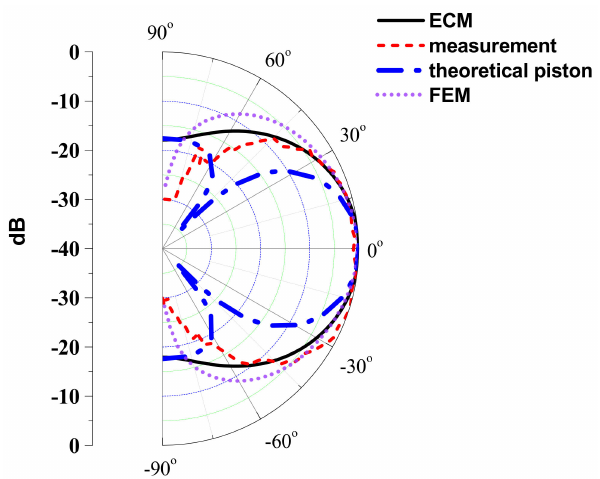
Figure 14. Comparison between analytical, simulated, and measured beam patterns of the ultrasonic